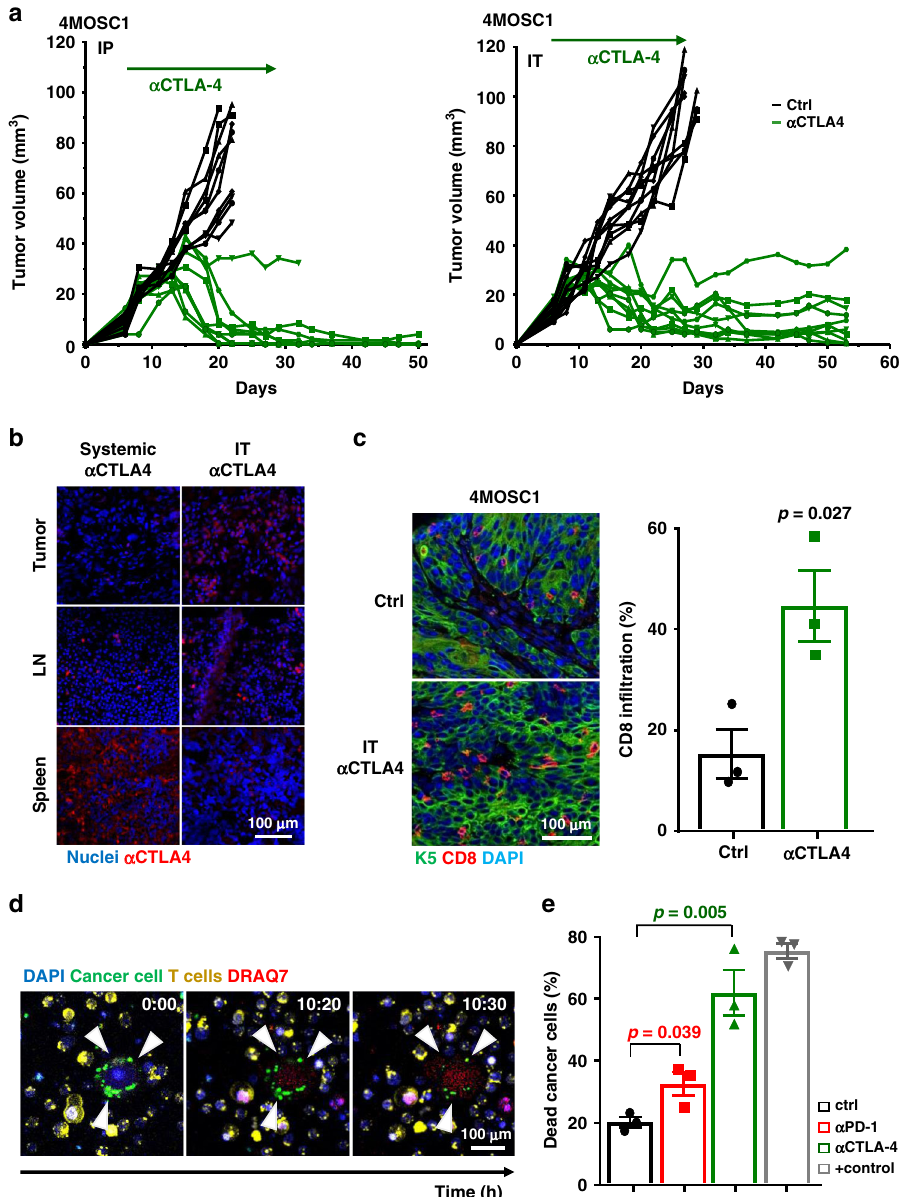
Fig. 5 Mice with 4MOSC1 tumors show nearly complete response to anti-CTLA-4. a C57Bl/6 mice were implanted with 1 × 10 6 of 4MOSC1 cells into the tongue. After the tumors reached ~30 mm 3 , mice were treated 10 mg/kg of isotype control or anti-CTLA-4 for IP administration (left), and 5 mg/kg of isotype control or anti-CTLA-4 for IT administration (right). Individual growth curves of 4MOSC1 tumor-bearing mice plotting primary tumor growth are shown ( n = 10 mice per group). b Shown is the immuno fl uorescent staining of the distribution of anti-CTLA-4 antibody for mice with 4MOSC1 tumors using IP or IT delivery of the treatment. Staining for anti-hamster IgG (red) showed the localization of anti-CTLA-4 antibody in the tongue, lymph nodes, and spleen of treated mice. DAPI staining for nuclei is shown in blue ( n = 4 mice per group). c Immuno fl uorescent staining of CD8 highlights an increase in CD8 T-cell recruitment with anti-CTLA-4 treatment. Quanti fi cation of CD8 T cells with or without anti-CTLA-4 treatment was done by immuno fl uorescent staining of tumor (CK5) in the tongue. Shown is the average CD8 positivity by three regions of interest (ROI) per mouse, quanti fi ed by Qupath software for each condition ( n = 3 mice per group two-sided Student ’ s t test; data are represented as mean ± SEM). Antigen speci fi c T-cell cytotoxic assay. C57Bl/6 mice were implanted with 1 × 10 6 of 4MOSC1 cells into the tongue, and when they reached ~30 mm 3 , mice were treated IT with isotype control, anti-PD-1, or anti-CTLA-4 every other day for three treatments total. CD8 T cells from each group were isolated and cocultured with preplated 4MOSC1 cells. DMSO (10%) was used to treat 4MOSC1 as a positive control, and DRAQ7 was added in the culture medium to mark dead cells (red). d Real time live-imaging experiments were performed using the 880 confocal fast scan (Zeiss), and representative images of tumor cell killing (CD8 T cells from anti-CTLA-4 group) are shown at the indicated times. e Quanti fi cation of dead cancer cells at the end of experiment. ( n = 3 mice per group; two-sided Student ’ s t test; data are represented as mean ±